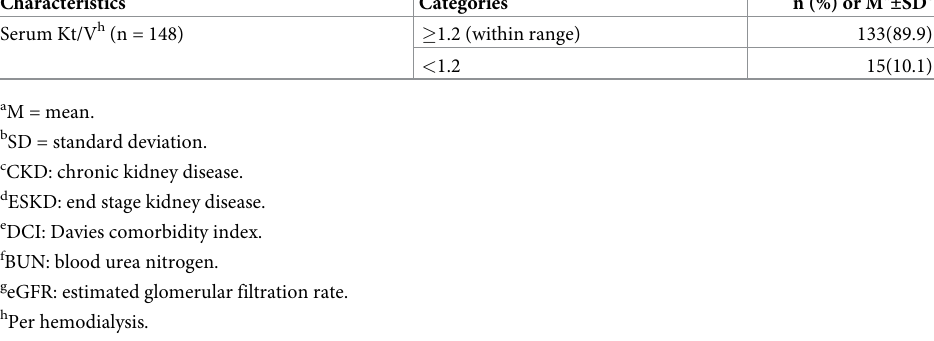
unemployed (t = -4.28, p < .001), and non-smokers (t = -3.63, p < .001). The mean CKDSC scores for the medical condition-related characteristics were significantly high for patients with end-stage kidney disease; those with a DCI score � 2 compared to those with a DCI score of 0; and those with abnormal levels of hemoglobin, calcium, creatinine, and eGFR (Table 3).